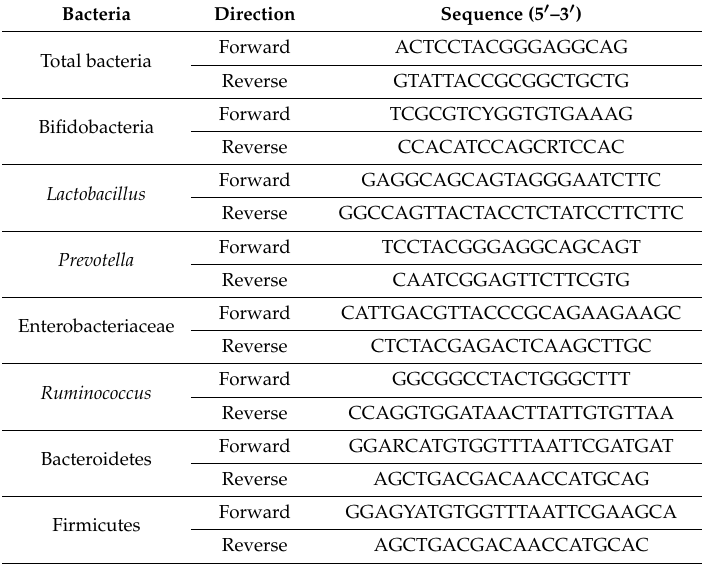
Table 1. Sequence of real-time PCR